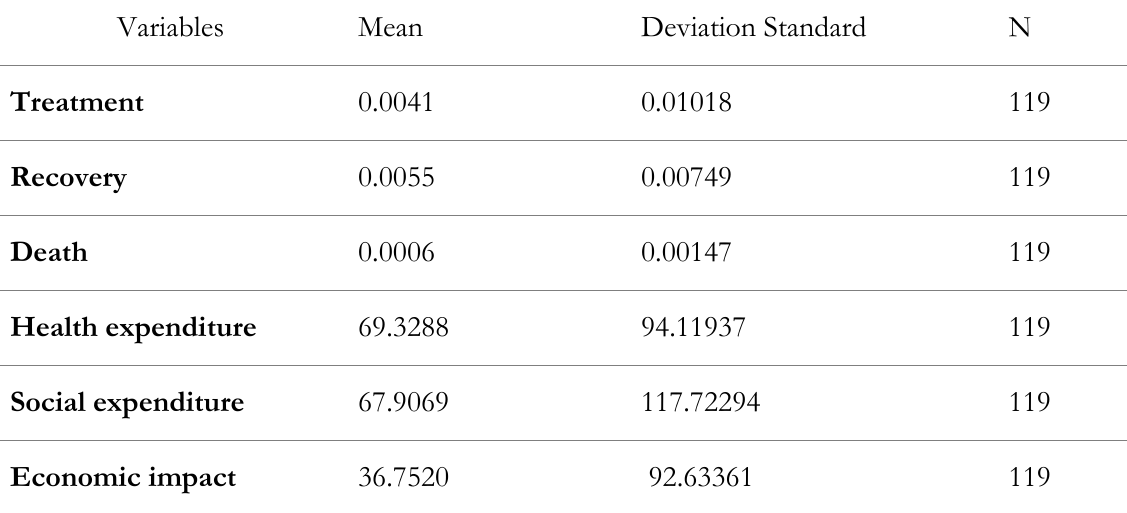
Table 1. Descriptive Statistics